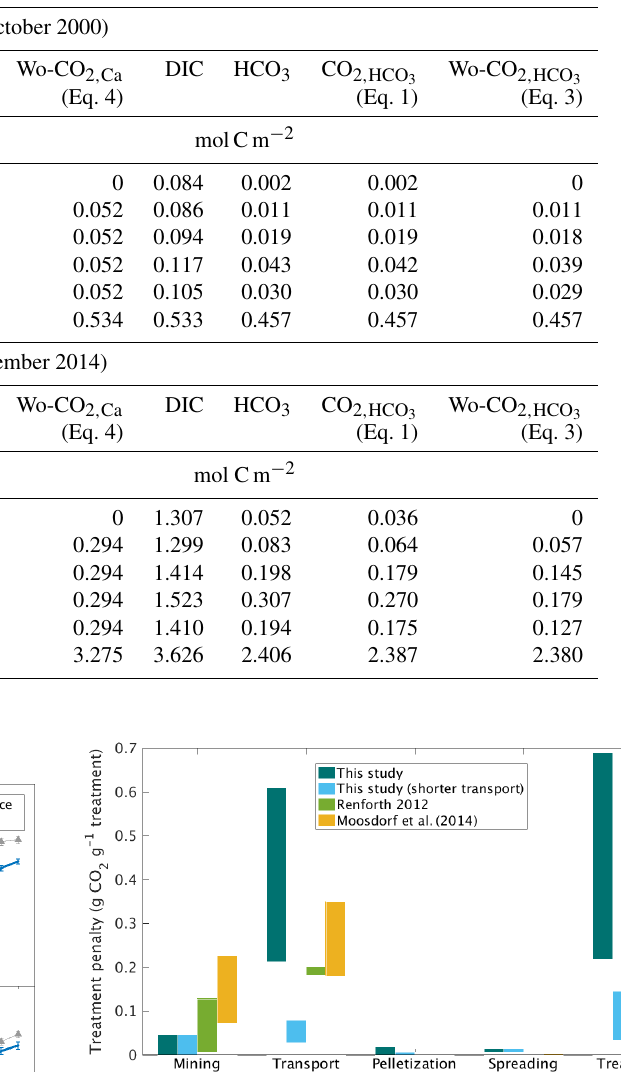
Table 3. Cumulative fluxes from treatment date calculated with stream-water partial pressure of CO 2 (gas) = 3.63 × atmospheric CO 2 partial pressure measured at Mauna Loa (Tans and Keeling, 2017) (see Methods). DIC: dissolved inorganic carbon. Scenarios are defined in the main text.